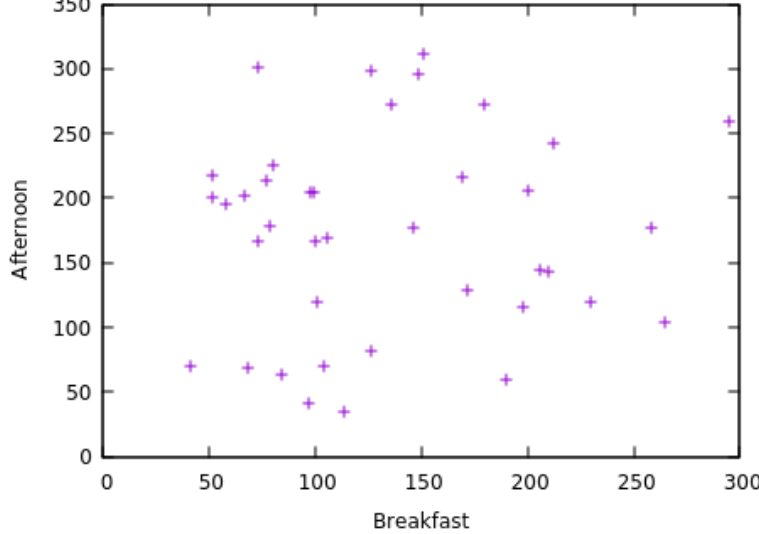
Figure 1. Scatter plot of a measurement at breakfast and in the afternoon on the same